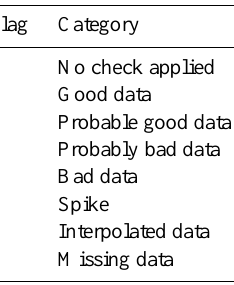
Table 1. Flag scale used in QC